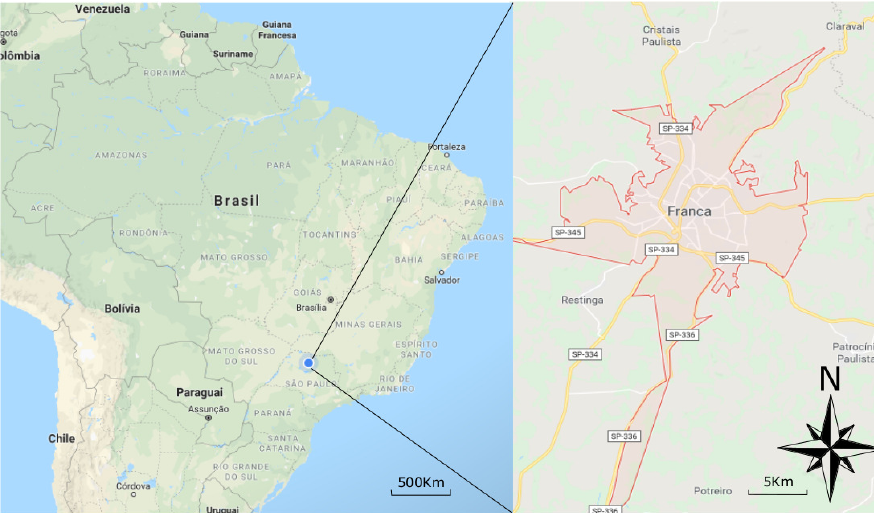
Figure 4. Location map of the city of Franca, Brazil.